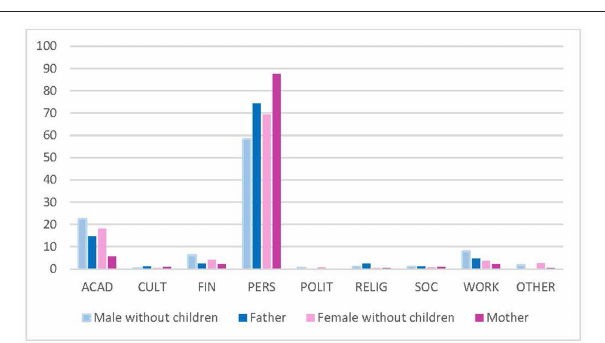
FIGURE 3 | Top reason to stay (gender and parenthood). ACAD, academic; CULT, cultural environment; FIN, financial; PERS, personal; POLIT, political; RELIG, religious; SOC, social. Data reported in %.